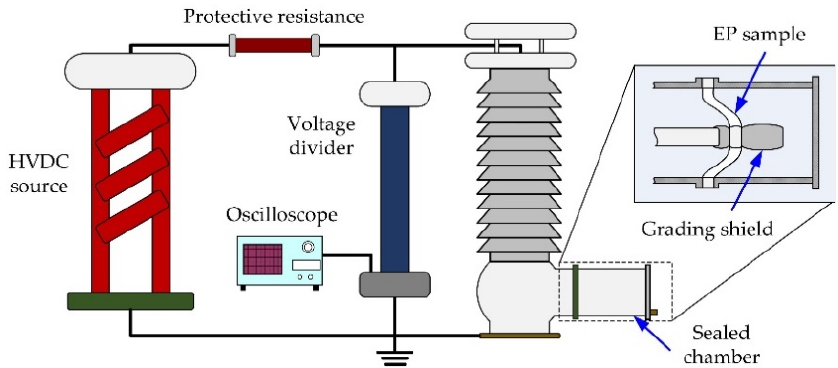
Figure 2. Schematic diagram of experiment circuit. The insert figure on upper right illustrates the inside view of the chamber.